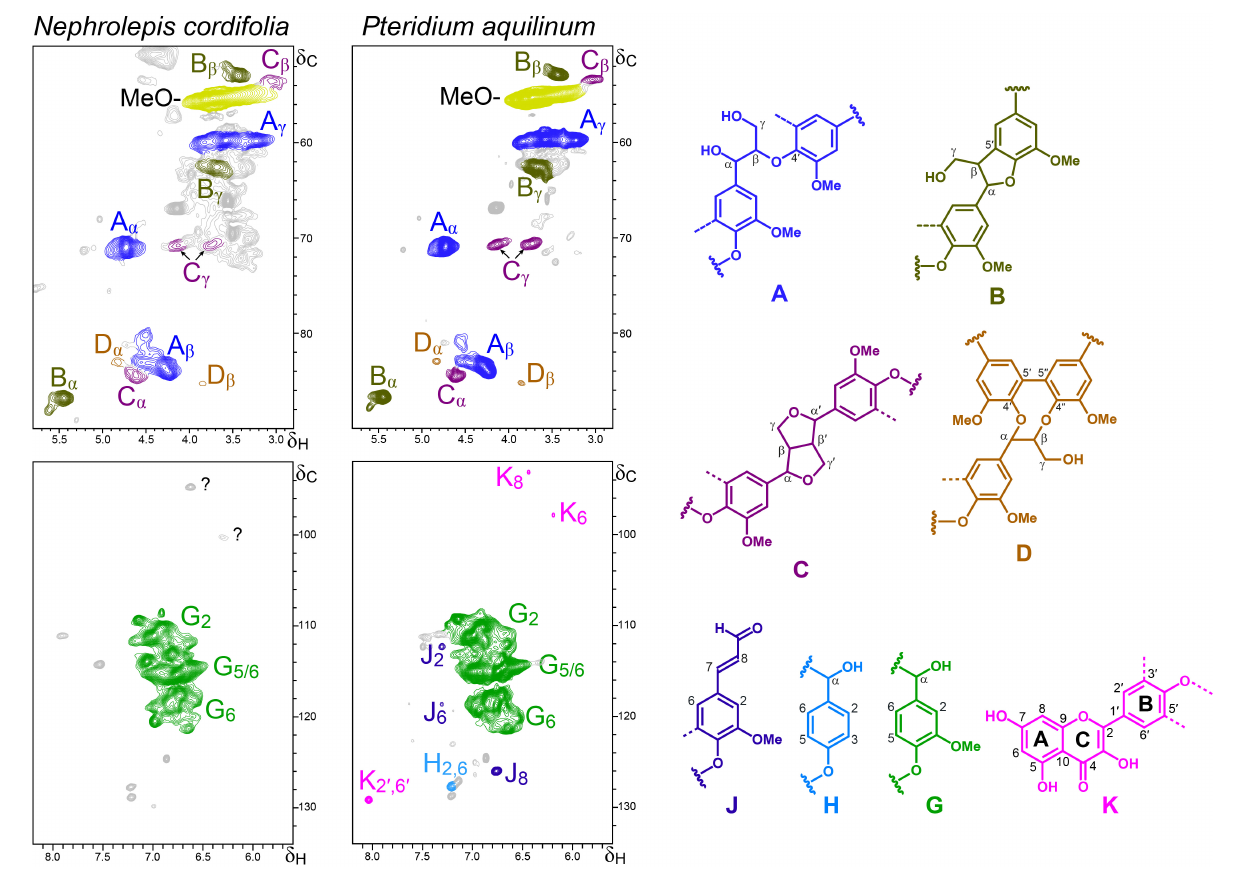
FIGURE 5 | Aliphatic-oxygenated ( δ C / δ H 50–90/2.8–5.8) and aromatic ( δ C / δ H 92–134/5.5–8.0) regions of the HSQC spectra of lignin-like preparations isolated from the ferns N. cordifolia and P. aquilinum . The main structures identified – corresponding to β – O –4 (cid:48) ether (A), β –5 (cid:48) phenylcoumaran (B), β – β (cid:48) resinols (C) and 5–5 (cid:48) dibenzodioxocins (D) side chains, p -hydroxyphenyl (H) and guaiacyl (G) units, coniferaldehyde end-groups (J), and kaempferol moieties (K) – are shown on the